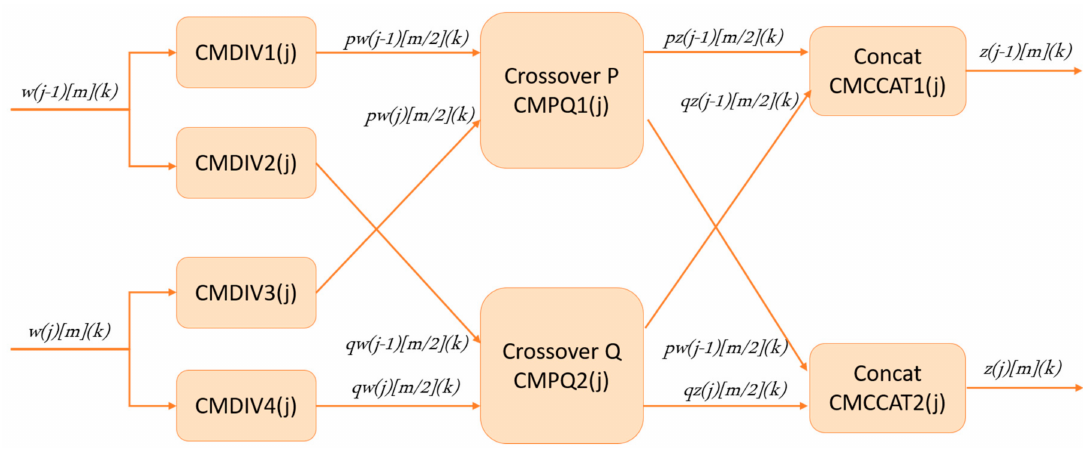
Figure 1. Crossover operators proposed in [11]. ( a ) One-point crossover and ( b ) multi-point crossover.